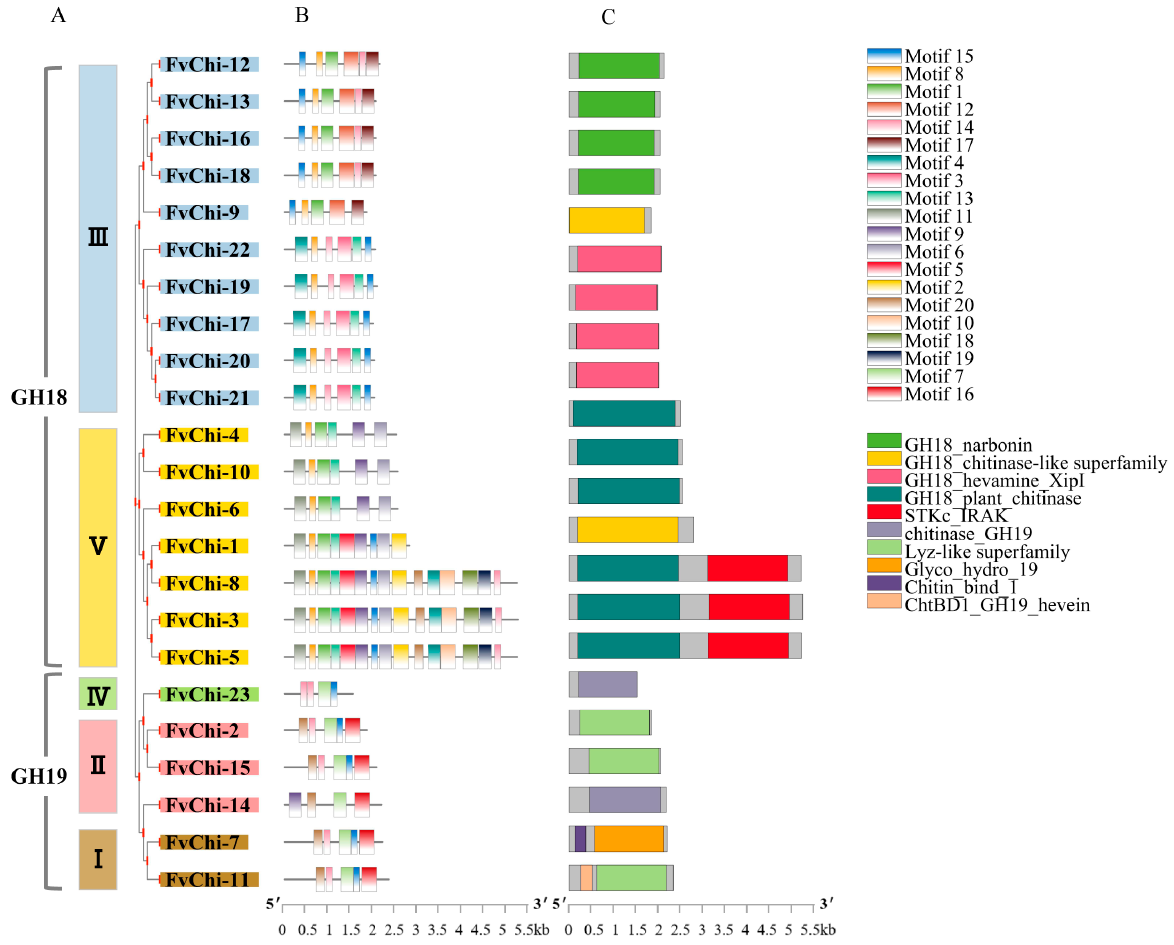
Figure 3. Gene structure analysis of FvChi . ( A ) Phylogenetic analysis and classification. Different boxes denote different subgroups. ( B ) Motif distribution patterns. ( C ) Domain distributions.